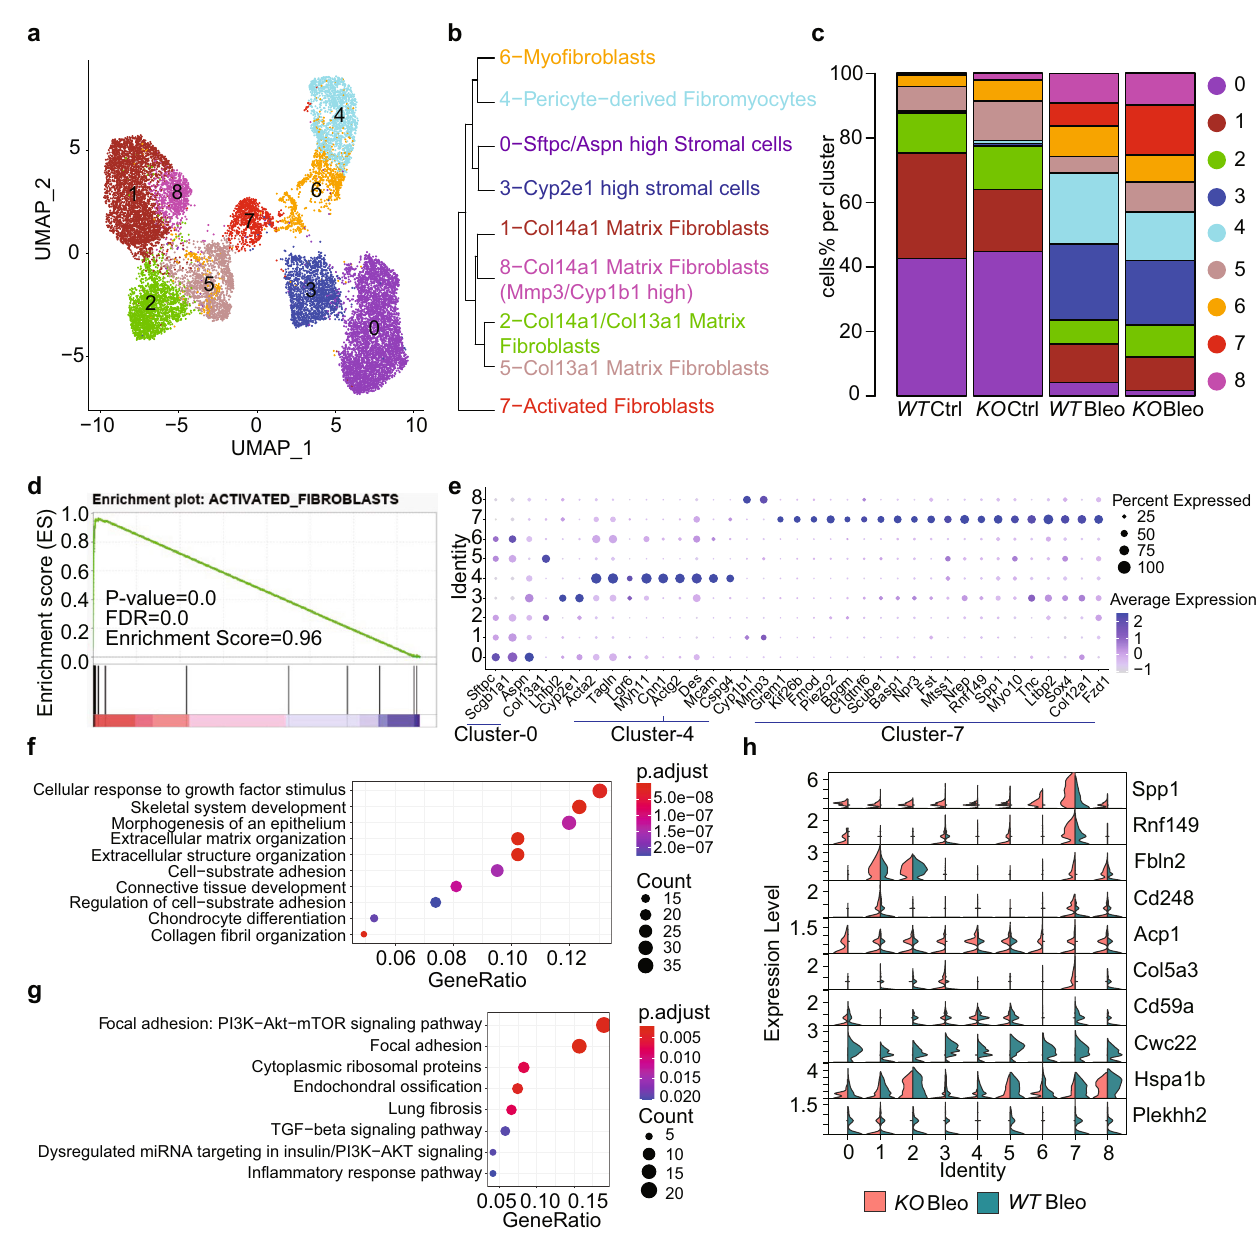
Fig.2| Pear1 de fi ciencyexpandedactivated fi broblastsinbleomodel.a – c Allof the 17,934 mesenchymal cells across four experiment conditions were integrated forumapclustering ( a ),celltype annotationandcluster-tree dendrogram ( b ),and fraction of each cell type in each experimental condition ( c ). d GSEA analysis of activated fi broblasts signature of cluster 7 compared with the rest clusters. e Dotplot of markers for the selected cluster. f , g Top 10 GO biological process ( f )